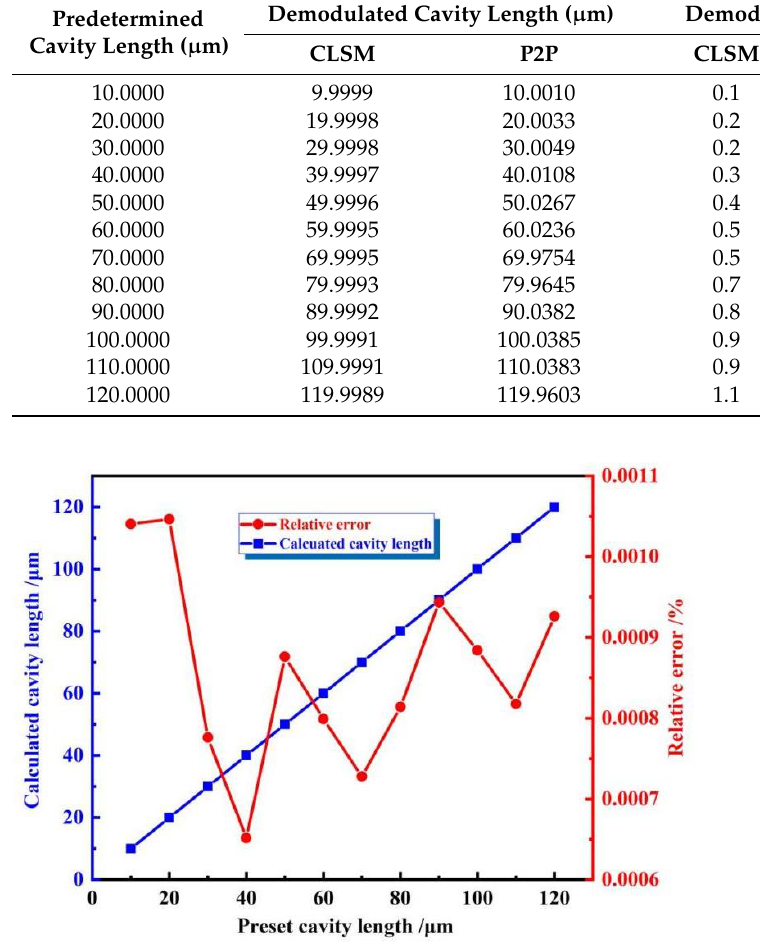
Figure 4. Relationships of the simulated cavity length and the error versus the preset cavity length.